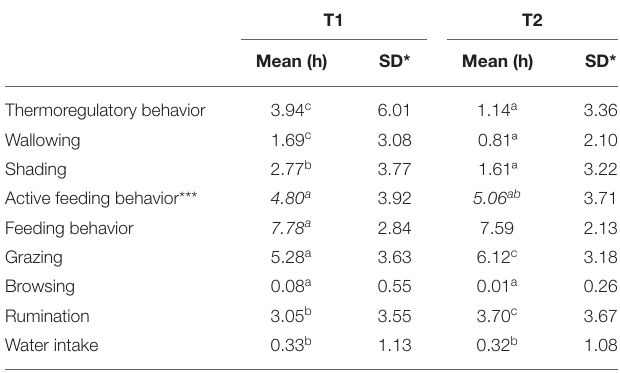
TABLE 4 | Thermoregulatory and feeding behavior in system without trees.